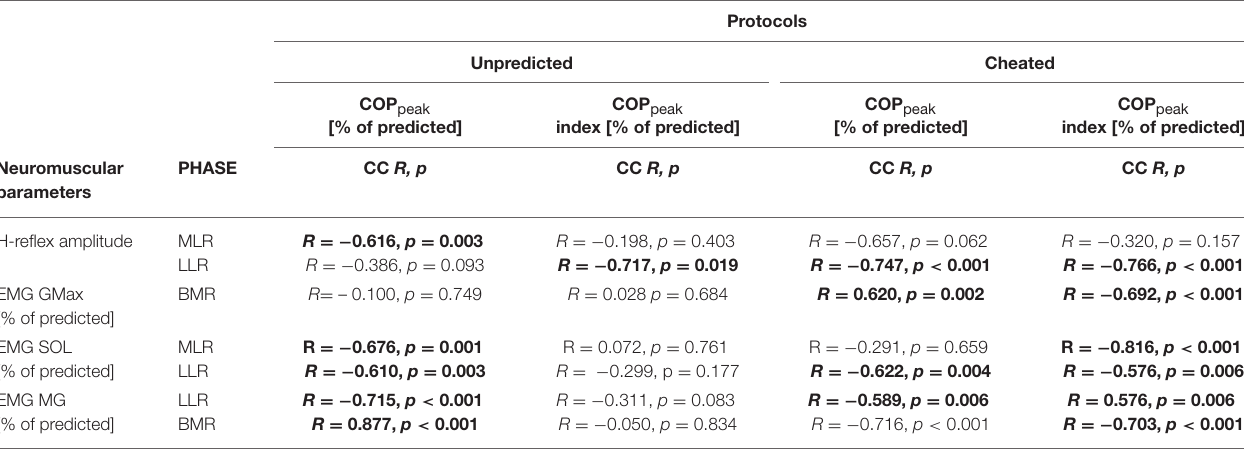
TABLE 4 | Bivariate Spearman-Rho correlation coefficients (CC), R and p -values among the variables COP peak and COP peak index with the normalized EMGs of GMax, BF, SOL, MG and TA in the relevant phases before and after perturbation: PRE (100ms before perturbation), SLR (30–60ms after perturbation onset), MLR